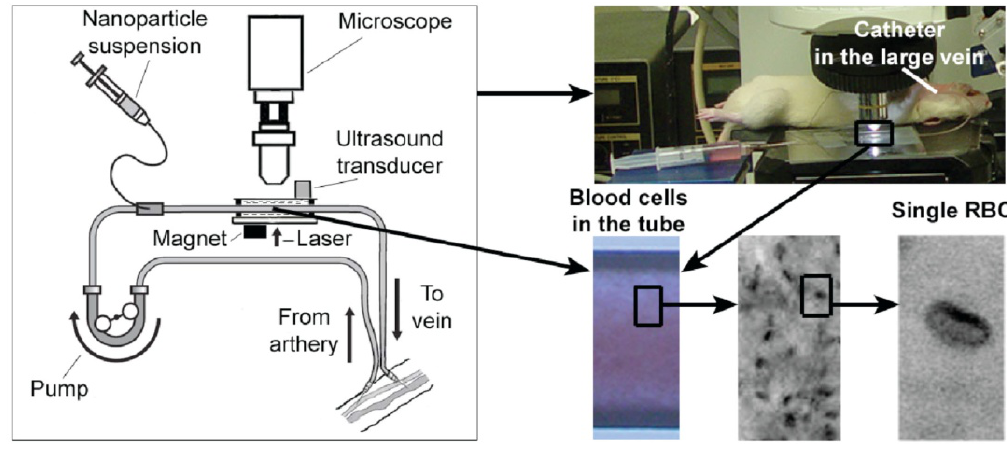
Figure 26. Principle and animal model for in vivo PA detection, molecular targeting, magnetic capturing and PT ablation of CTCs in blood with an extracorporeal